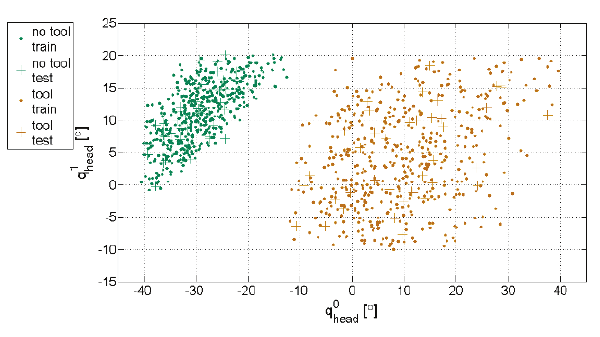
Figure 15. Distribution of head joints values (i.e. model output) during motor babbling. Green color indicates without tool, brown color with tool. Dots indicates training samples, crosses test samples.